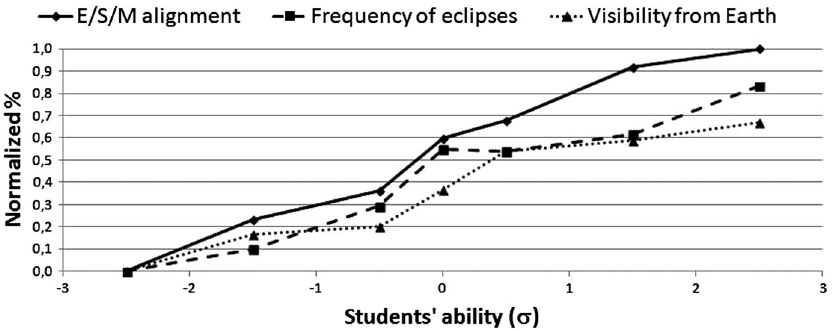
FIG. 6. Item response curves for eclipses